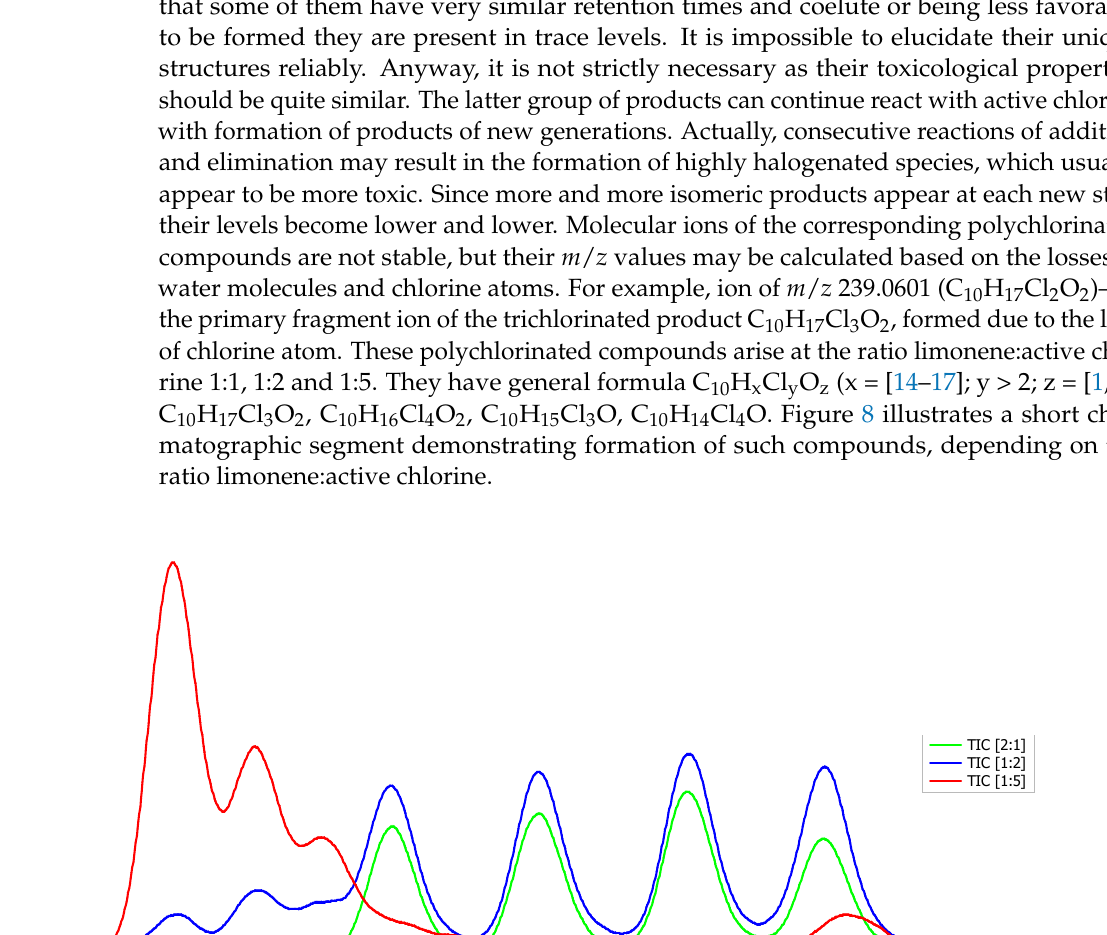
Figure 7. TIC chromatogram segment demonstrating four secondary products of limonene aqueous chlorination.